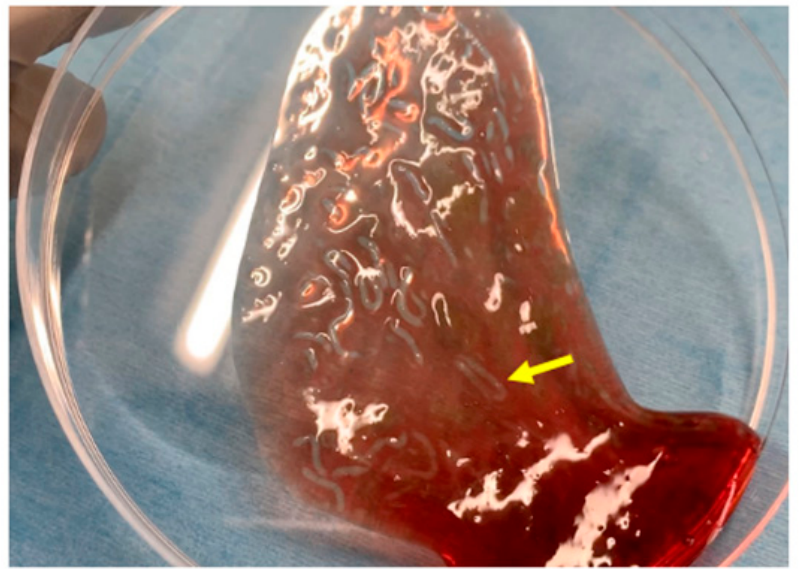
Figure 1. Images of PuraStat. After PuraStat injection into the blood, gel formation is observed (yellow arrow).